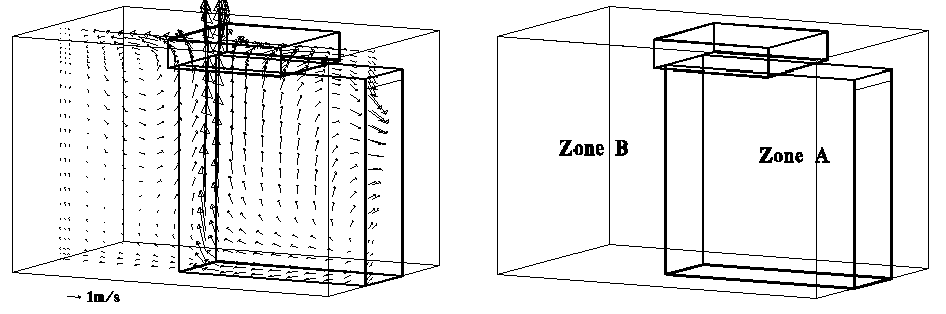
Figure 2. Location of Zone A and B.